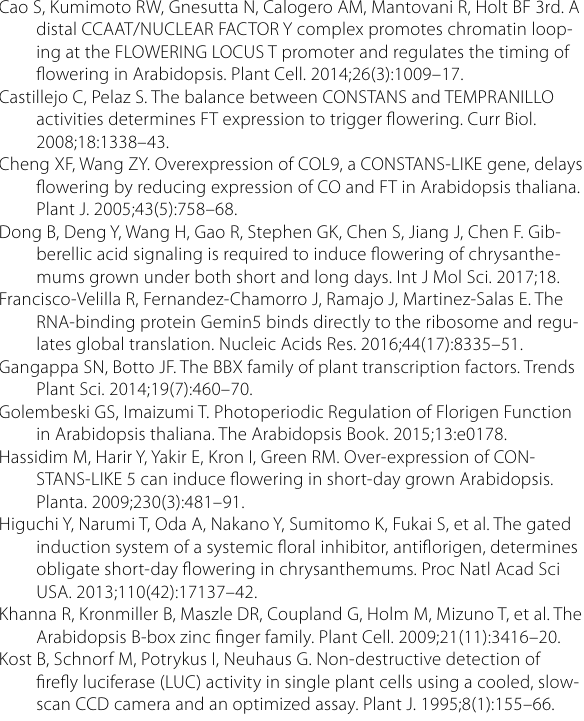
tary Table S3. Primer sequences for qRT-PCR. Supplementary Table S4. Primer sequences for EMSA. Additional file 2: Supplementary Figure S1. Transcriptional activation of CmBBX7. Additional file 3: Supplementary Figure S2. Subcellular localization of